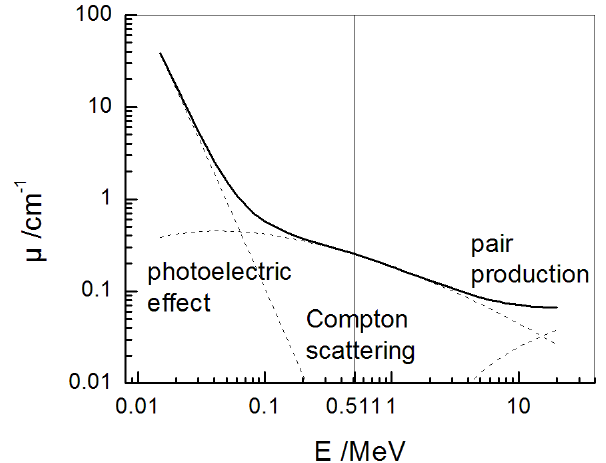
Figure 1. Linear attenuation coefficient µ of anhydrite, calculated with data from XCOM (Berger et al., 2010). The effective absorp- tion process at 511keV is Compton